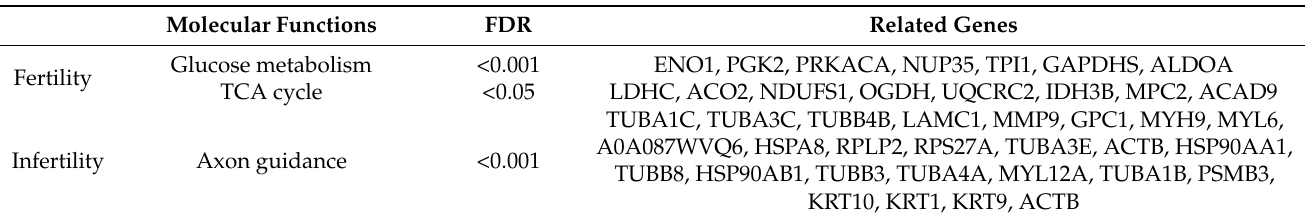
Table 4. Summary of signaling pathways associated with fertility- and infertility-related proteins in human spermatozoa. Molecular